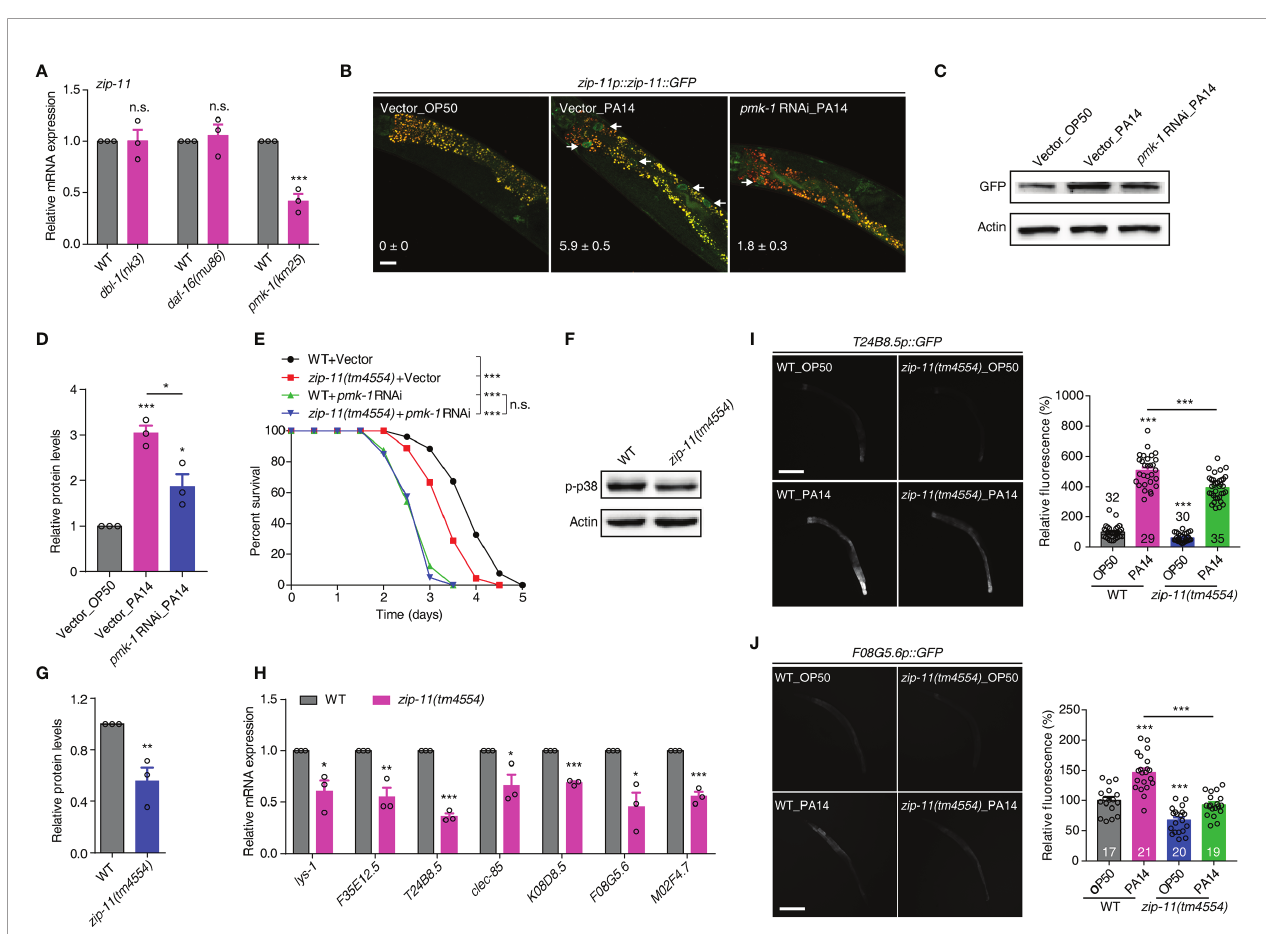
FIGURE 3 | The conserved PMK-1/p38 pathway is required for the attenuated resistance to P. aeruginosa infection of zip-11 mutants. (A) qRT-PCR analysis of zip- 11 expression in WT, dbl-1(nk3) , daf-16(mu86) or pmk-1(km25) worms. (B) Representative images of the zip-11p::zip-11::GFP worms exposed to E. coli OP50 or P. aeruginosa PA14 after being fed with vector control or pmk-1 RNAi bacteria. Mean percentages of ZIP-11::GFP nuclear accumulation in the anterior portion of intestinal tissue (white arrows) are indicated. n ≥ 15. Scale bar: 20 m m. (C) Western blots of zip-11p::zip-11::GFP worms exposed to E. coli OP50 or P. aeruginosa PA14 after being fed with vector control or pmk-1 RNAi bacteria. (D) Quanti fi cation of the protein expression levels using the software program ImageJ. (E) WT worms and zip-11(tm4554) worms fed with vector control, pmk-1 RNAi bacteria were exposed to P. aeruginosa PA14 and scored for survival. (F) Western blot analysis of p38 phosphorylation levels in WT and zip-11(tm4554) worms. (G) Quanti fi cation of the protein expression levels using the software program ImageJ. (H) qRT-PCR analysis of the expression of PMK-1-dependent genes in WT and zip-11(tm4554) worms. (I) Representative images and quanti fi cation of T24B8.5p:: GFP in WT and zip-11(tm4554) mutant background exposed to E. coli OP50 or P. aeruginosa PA14. The number of animals analysed is indicated. Scale bar: 200 m m. (J) Representative images and quanti fi cation of F08G5.6p::GFP in WT and zip-11(tm4554) mutant background exposed to E. coli OP50 or P. aeruginosa PA14. The number of animals analysed is indicated. Scale bar: 200 m m. Data are presented as mean ± SEM. Statistical signi fi cance was determined by log-rank test (E) or Student ’ s t -test (A, D, G-J) . *p < 0.05, **p < 0.01, ***p < 0.001 compared with respective controls unless speci fi cally indicated; n.s., not signi fi cant. Please see Table S4 in Supplementary Material for detailed statistical analysis of killing assay